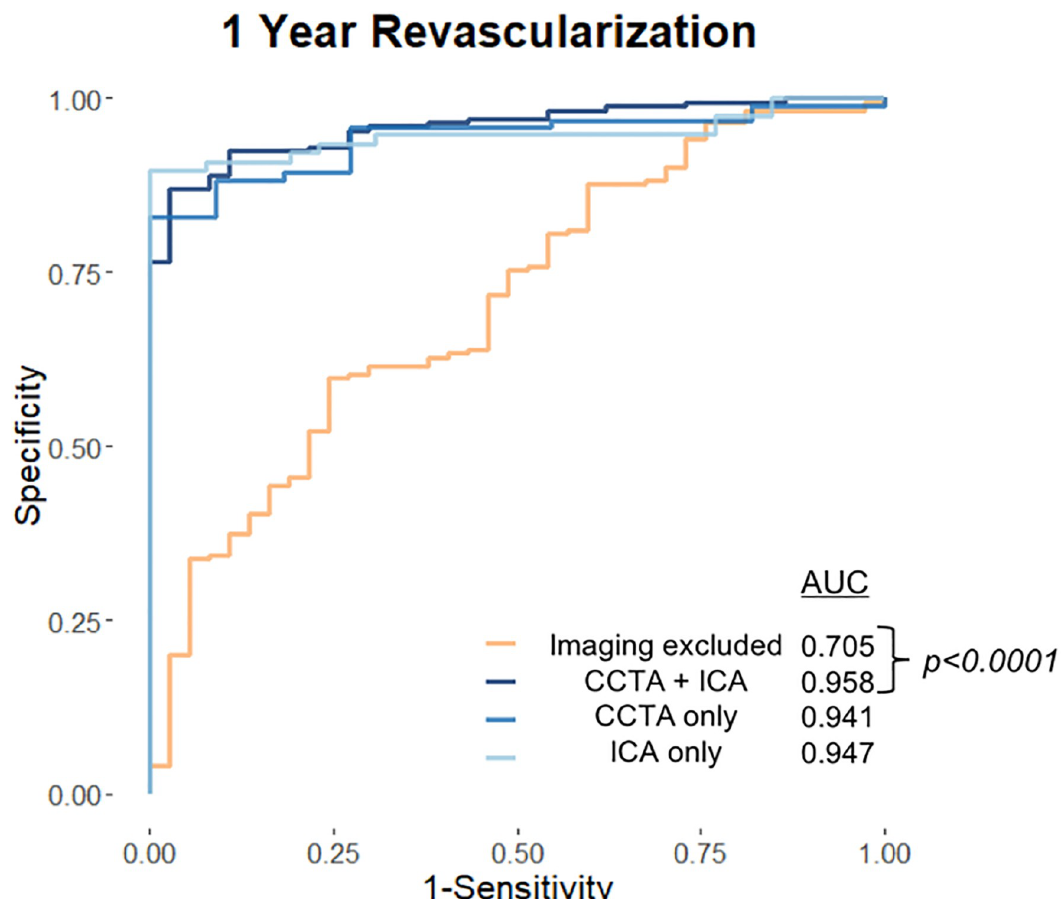
Fig 4. Receiver Operating Characteristics (ROC) analysis for the prediction of 1-year revascularization using non-imaging variables only (orange) and incorporating imaging variables (blue shades). Abbreviations: AUC = Area under curve, CCTA = Coronary computed tomographic angiography, ICA = Invasive coronary